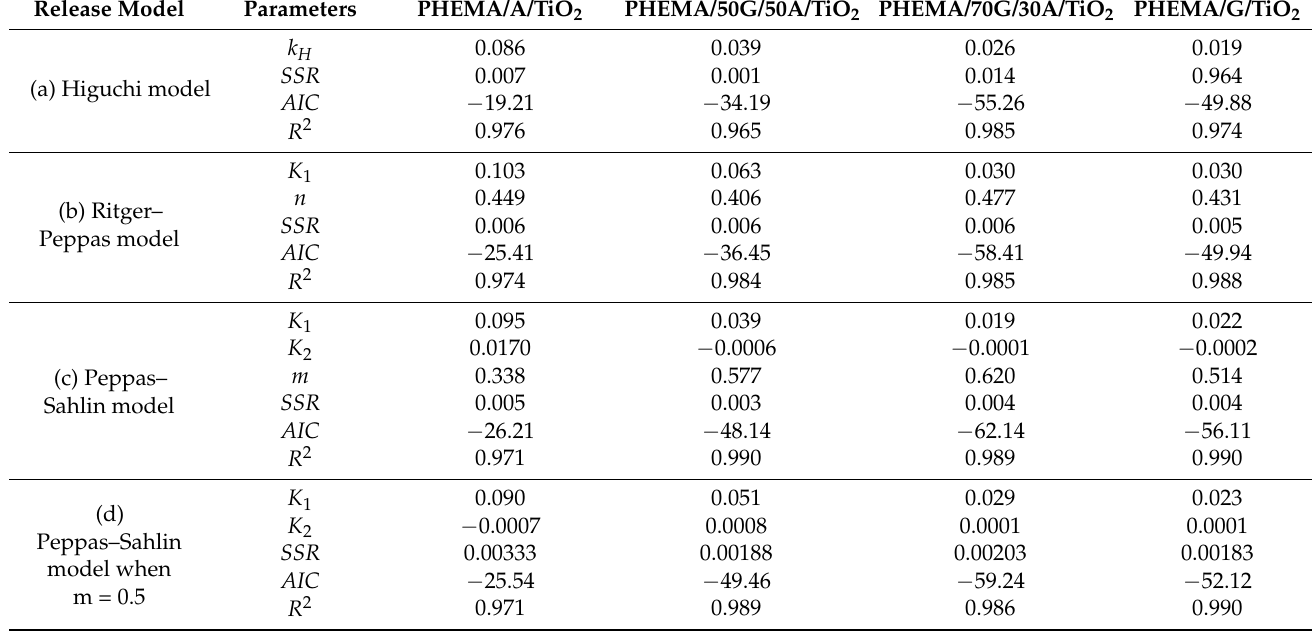
2. Curcumin data